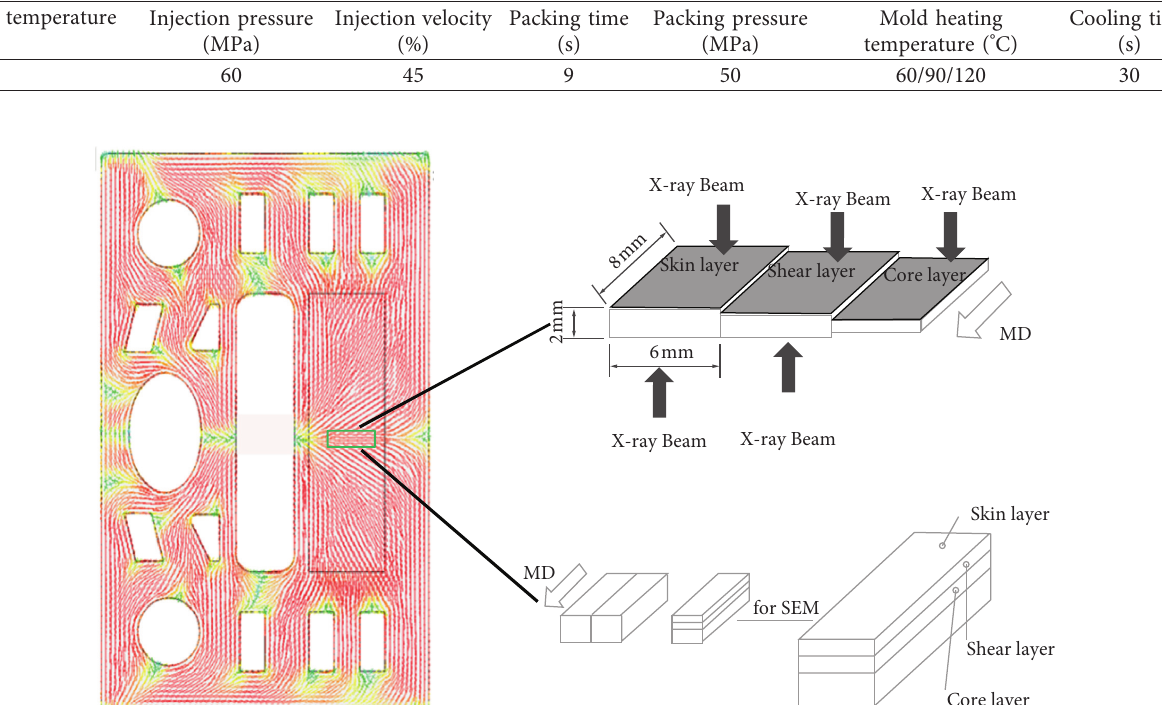
Figure 2: Schematic of parts and locations of tested